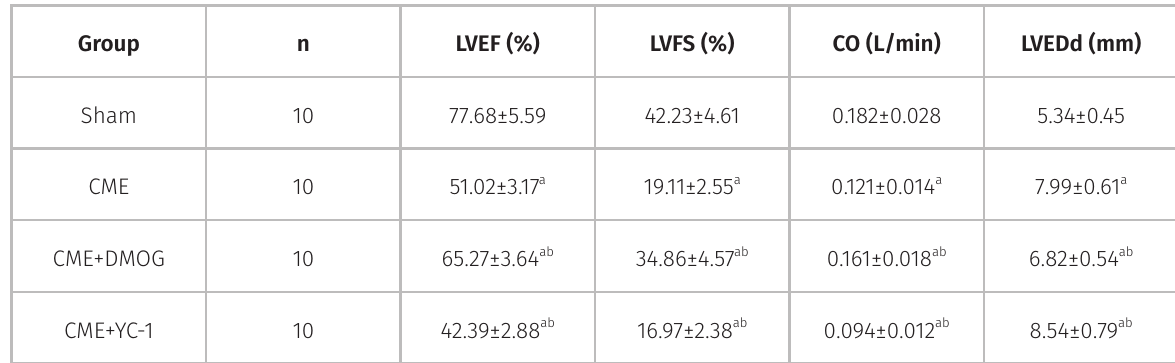
LVEF, left ventricle ejection fraction; CO, cardiac output; LVEDd, left ventricular end-diastolic diameter; LVFS, left ventricle fractional shortening; CME, coronary microembolization. a P <0.05 in comparison to Sham group; b P <0.05 in comparison to CME